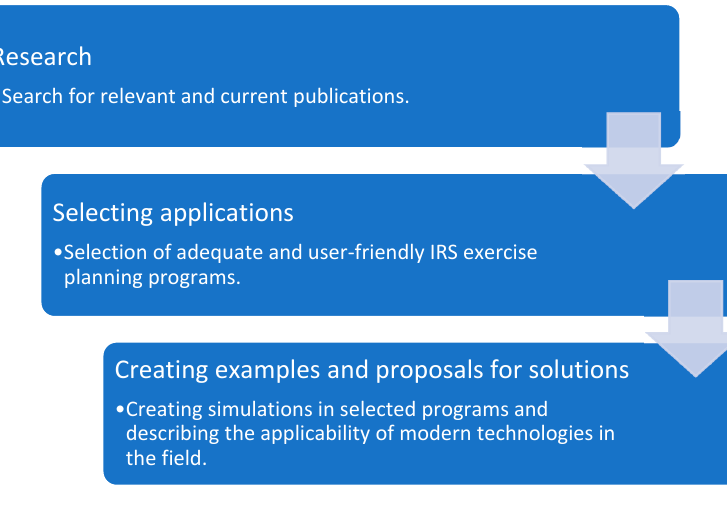
Figure 1. Flowchart of the proposed methodology.